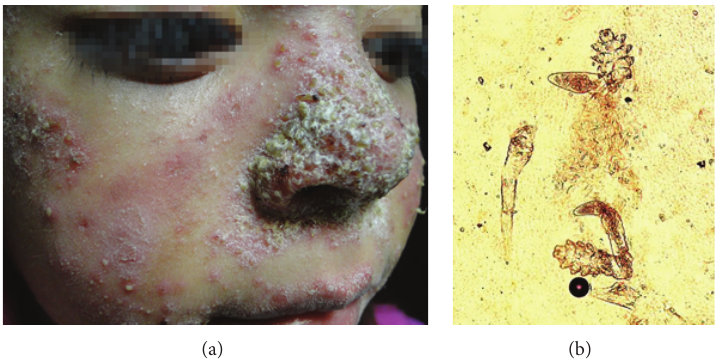
Figure 1: (a) Facial erythema, grayish crusted lesions, papules, and pustules. (b) Skin scraping revealing D. folliculorum mites.